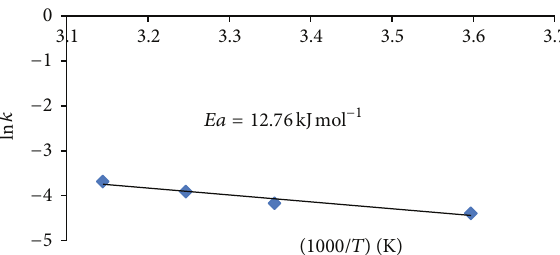
Figure 4: Arrhenius plot for photocatalytic degradation of Anthracene on TiO 2 at (278.15–308.15) K.